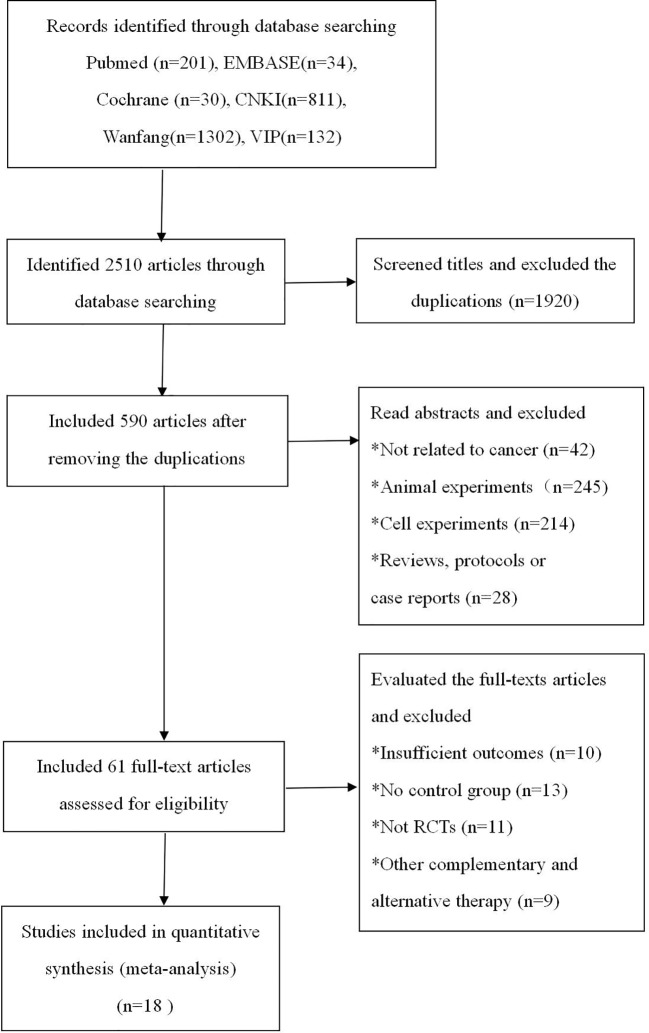
Flow diagram of the literature seaXMrch.